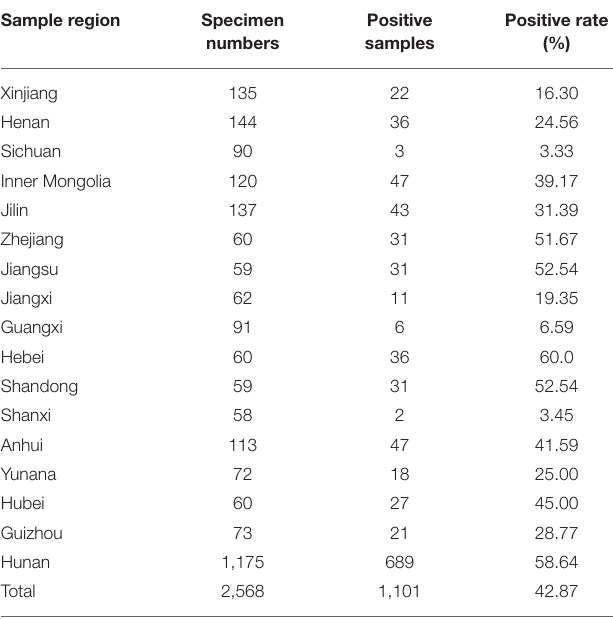
TABLE 1 | Seroprevalence of PCV3 in serum samples from different provinces of China by ELISA. Sample region